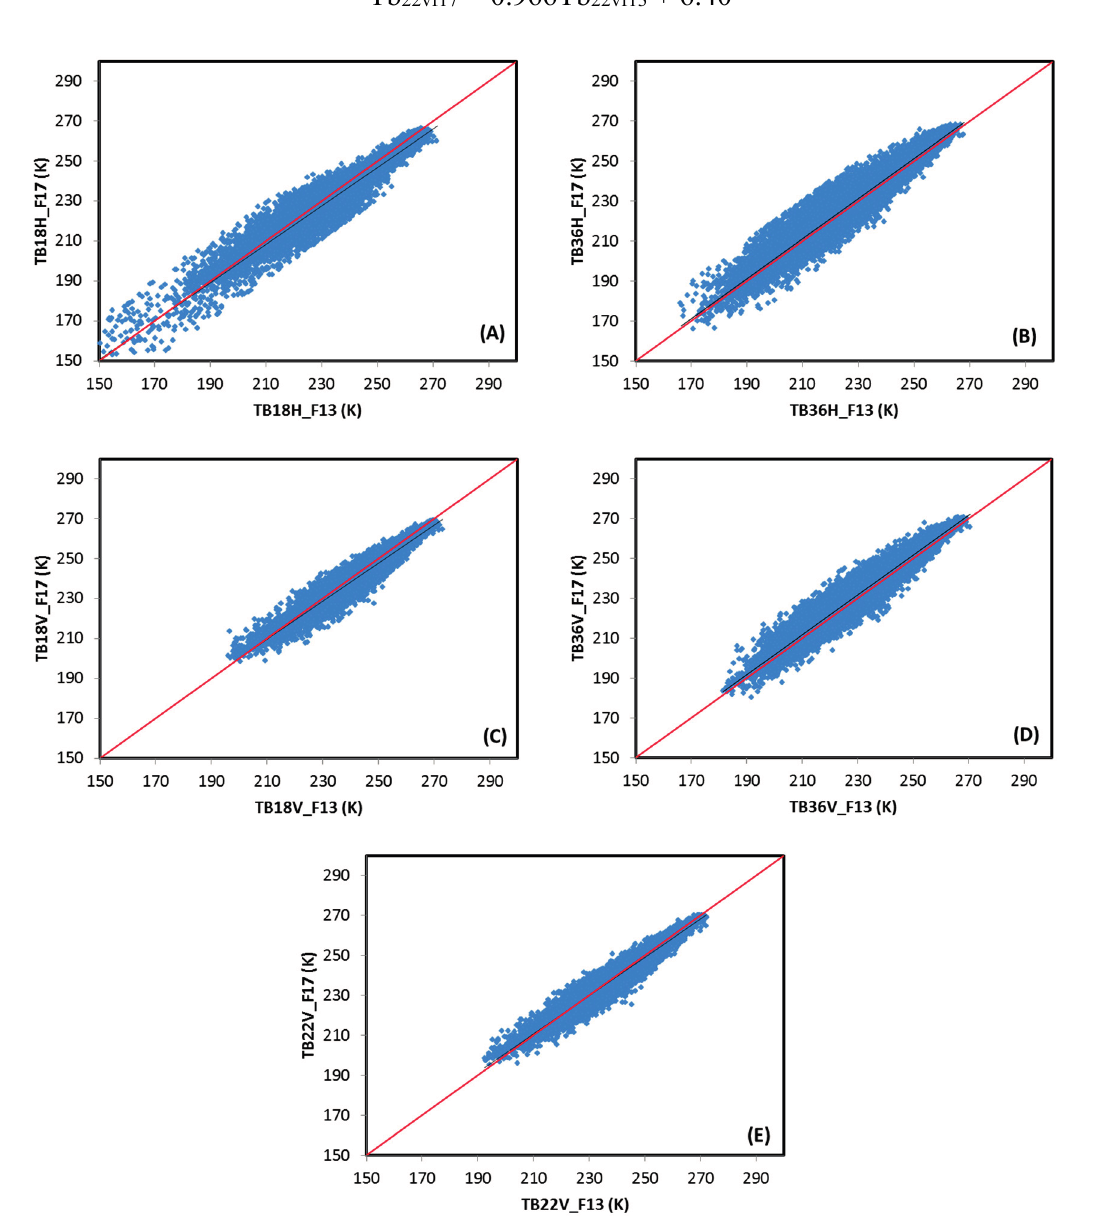
Figure 1. Scatter plots between the brightness temperatures from SSM/I(F13) and SSMI/S(F17): ( A ) 18H; ( B ) 36H; ( C ) 18V; ( D ) 36V; and ( E ) 22V. Based on Equations (1–5), the brightness temperatures at all channels from SSM/I(F13) were calibrated. The calibrated brightness temperatures were denoted by F13C. We plotted the histograms of brightness temperatures at all channels over China land on the overlap times of F13, F17 and